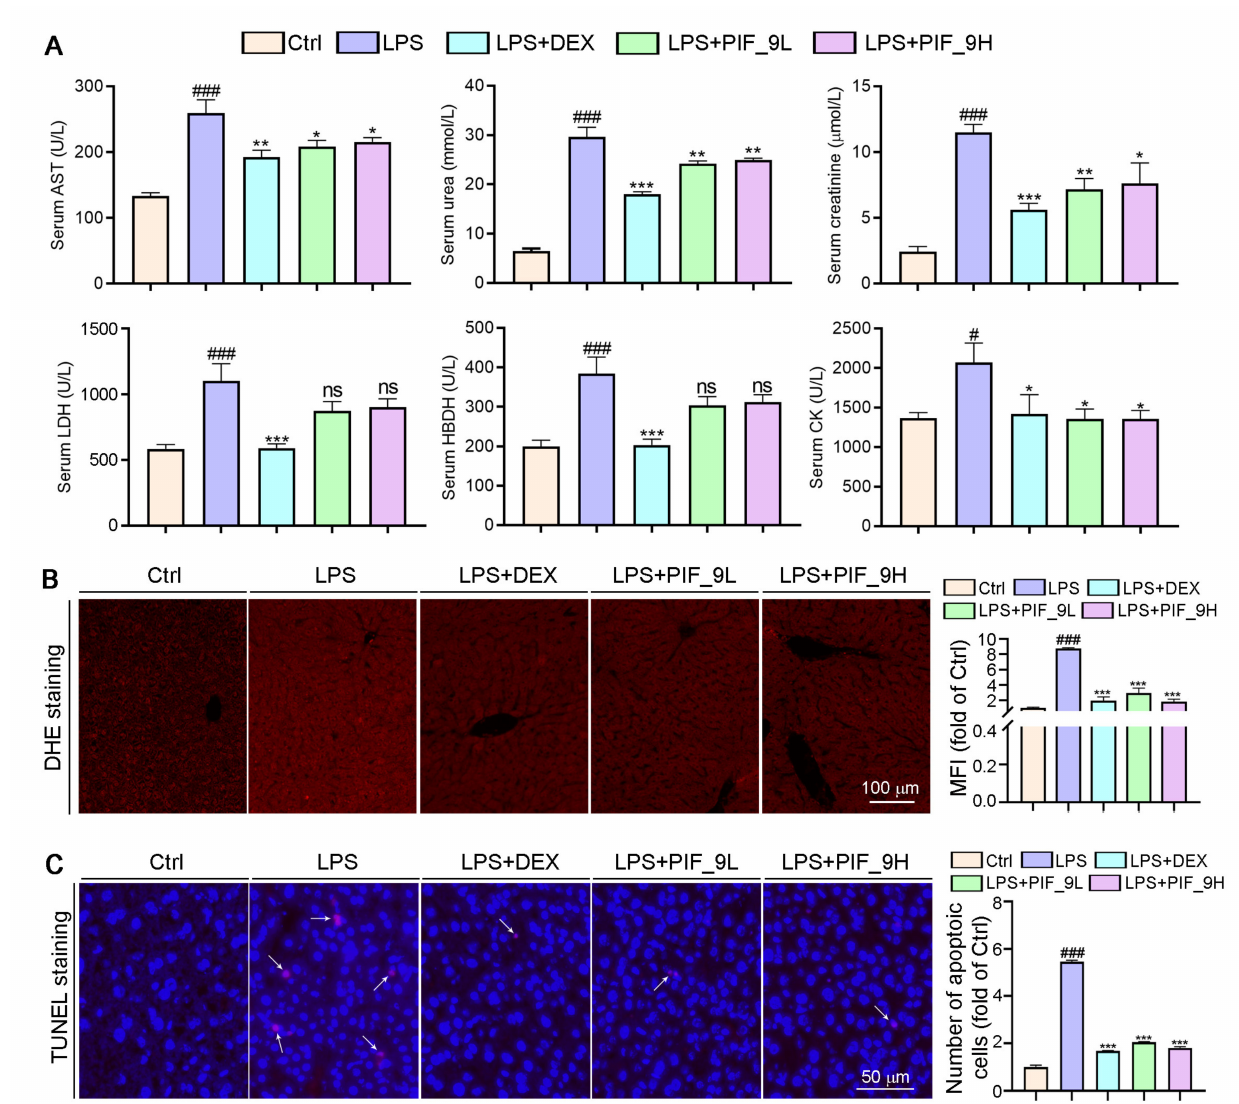
Figure 7. Compound PIF_9 reduced serum Urea, Crea, LDH, HBDH, and AST levels in sepsis mice. ( A ) At the end of the experiment, the serum was collected and diluted with PBS, followed by a determination of AST, UREA, CREA, LDH, and HBDH levels using automatic biochemical analyzer. ( B ) Measurements of 5- µ m liver paraffin sections were stained with DHE staining for determination of ROS levels as described in Materials and Methods; the representative photographs are presented. ( C ) TUNEL assay with quantitation of cell apoptosis in mouse liver tissues as described in Materials and Methods. The white arrows indicate apoptotic cells. The data were conducted with one-way ANOVA followed by hoc Bartlett’s test. # , p < 0.05, ### , p < 0.001 vs. Control group; *, p < 0.05, **, p < 0.01, ***, p < 0.001 vs. LPS group; ns, no significant difference ( n =